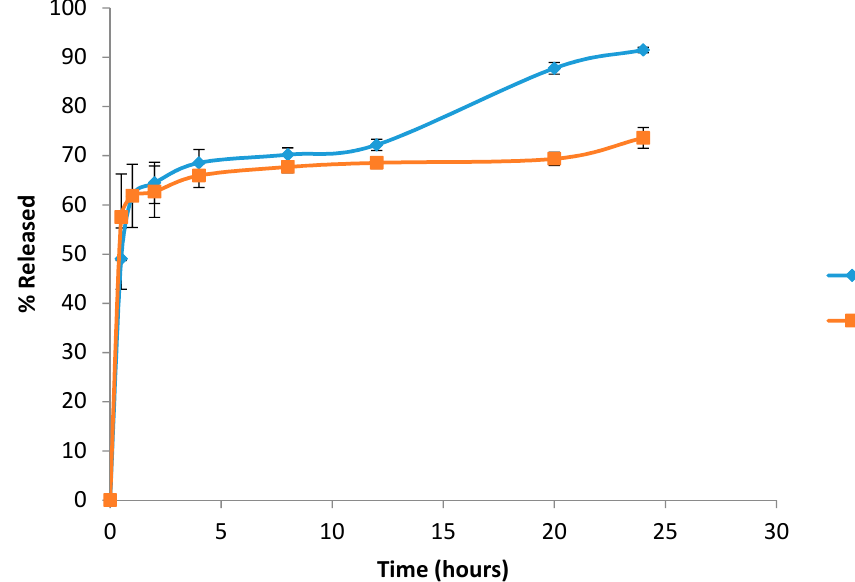
Figure 12. Pharmaceutics 2019 , 11 , x FOR PEER REVIEW